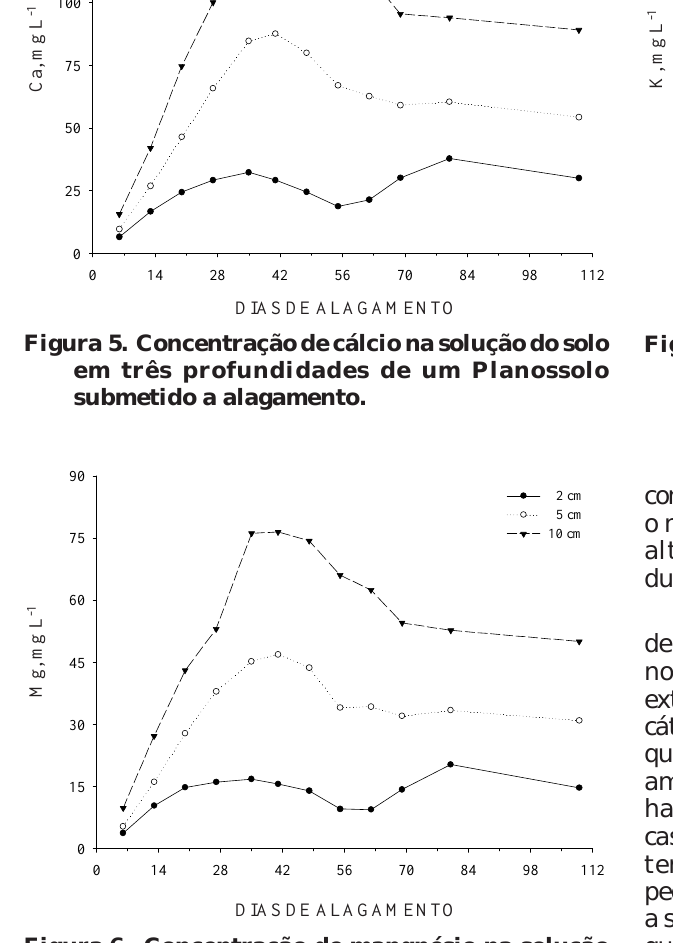
Figura 6. Concentração de mangnésio na solução do solo em três profundidades de um Planossolo submetido a alagamento.